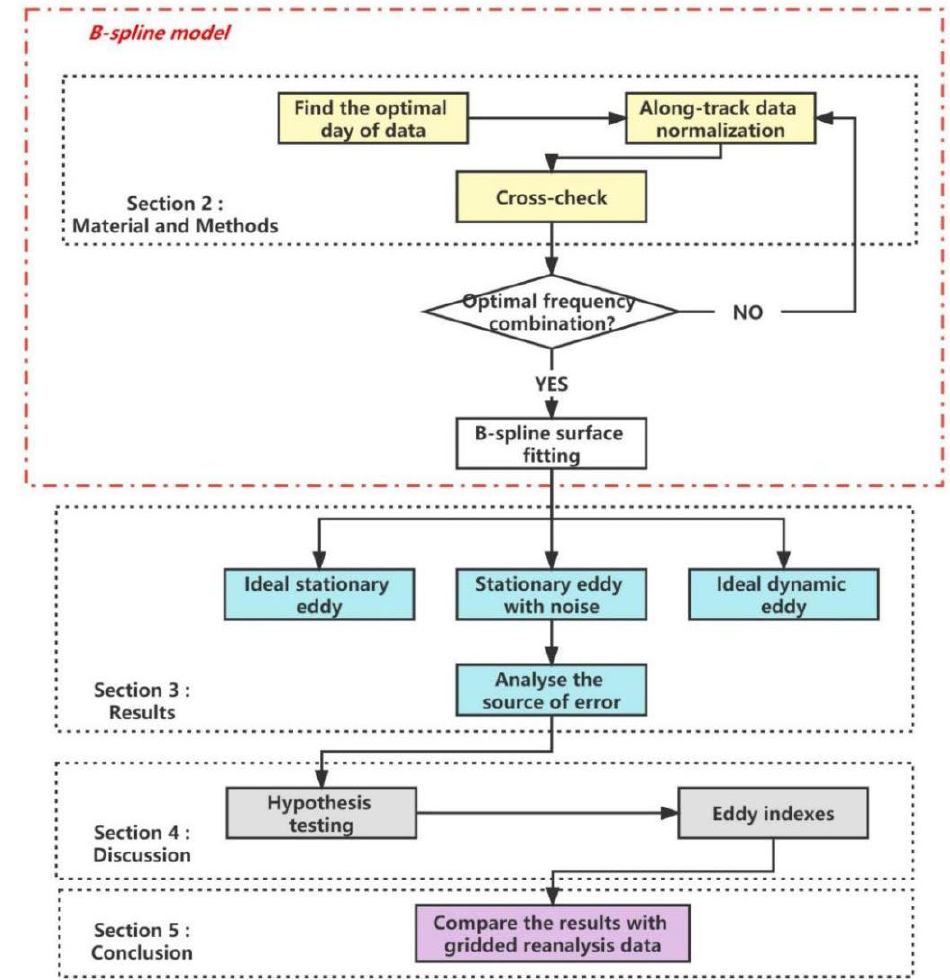
Figure 1. The framework of the B-spline surface fitting.